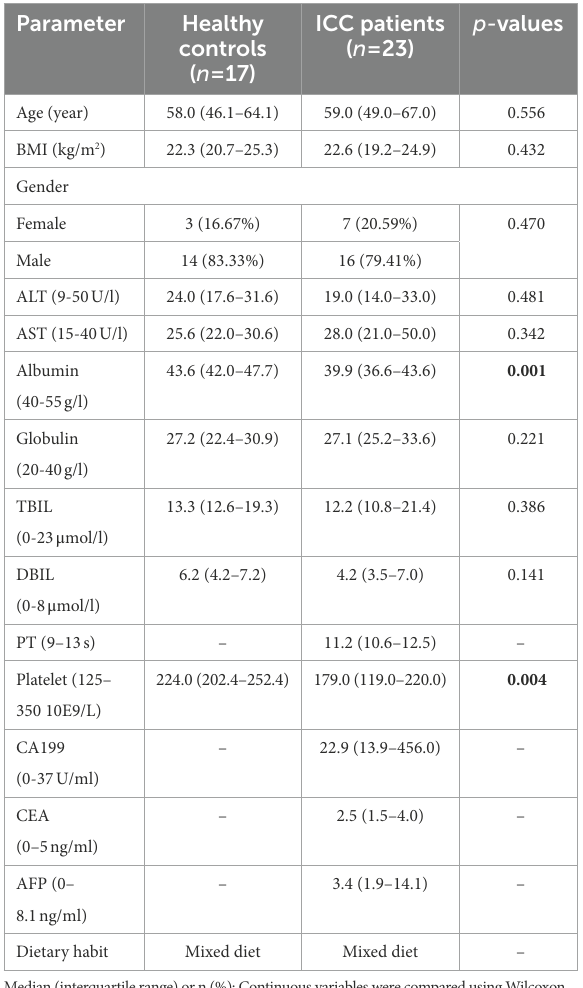
TABLE 1 Clinical characteristics of the enrolled